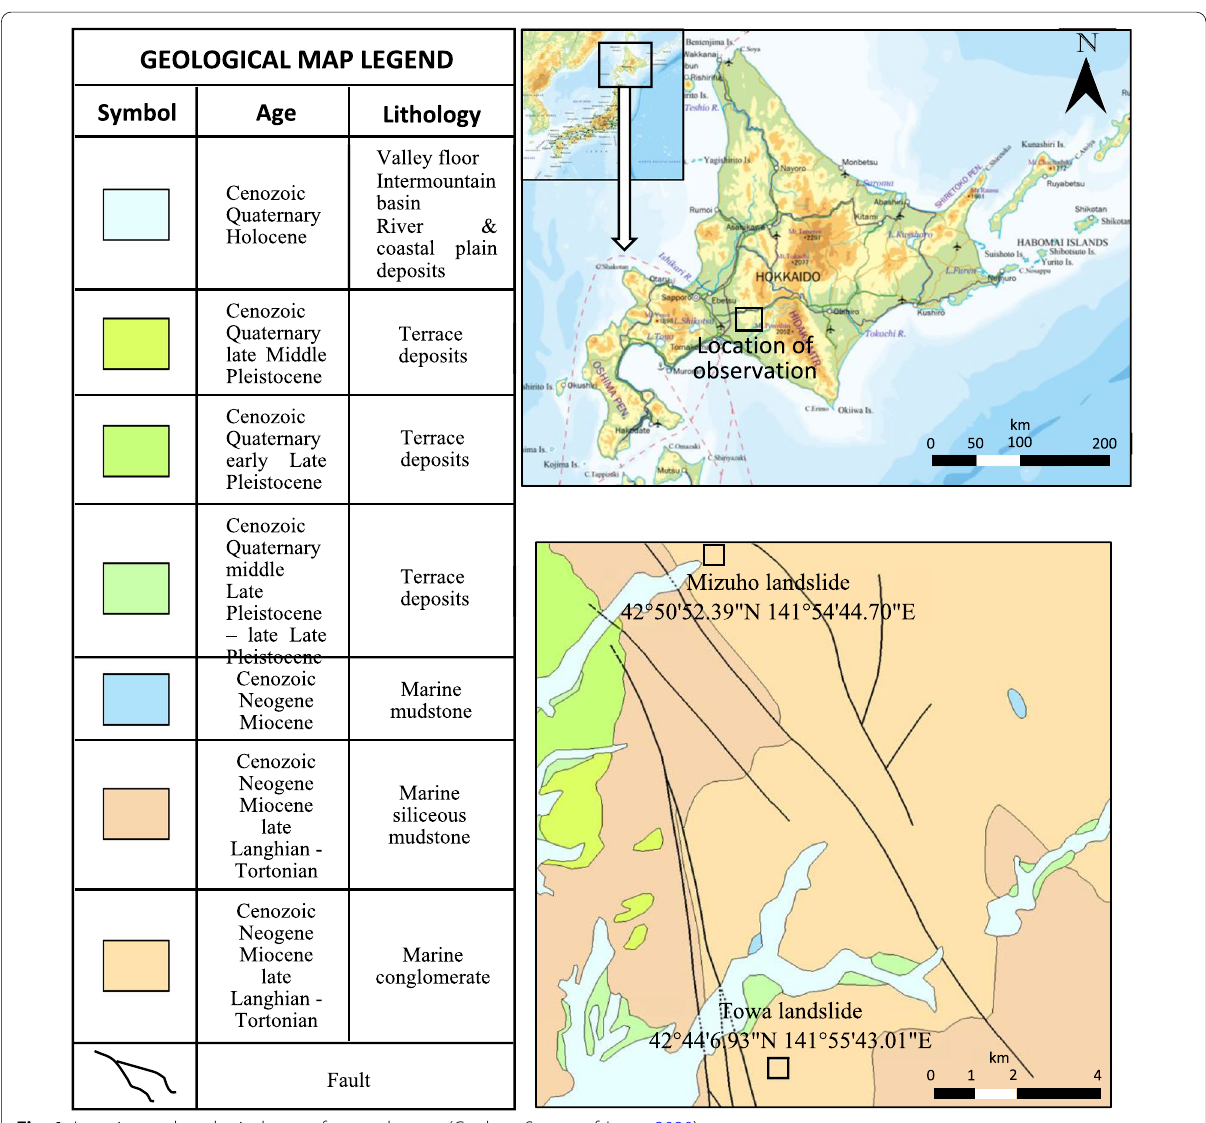
Fig. 1 Location and geological map of research areas (Geology Survey of Japan